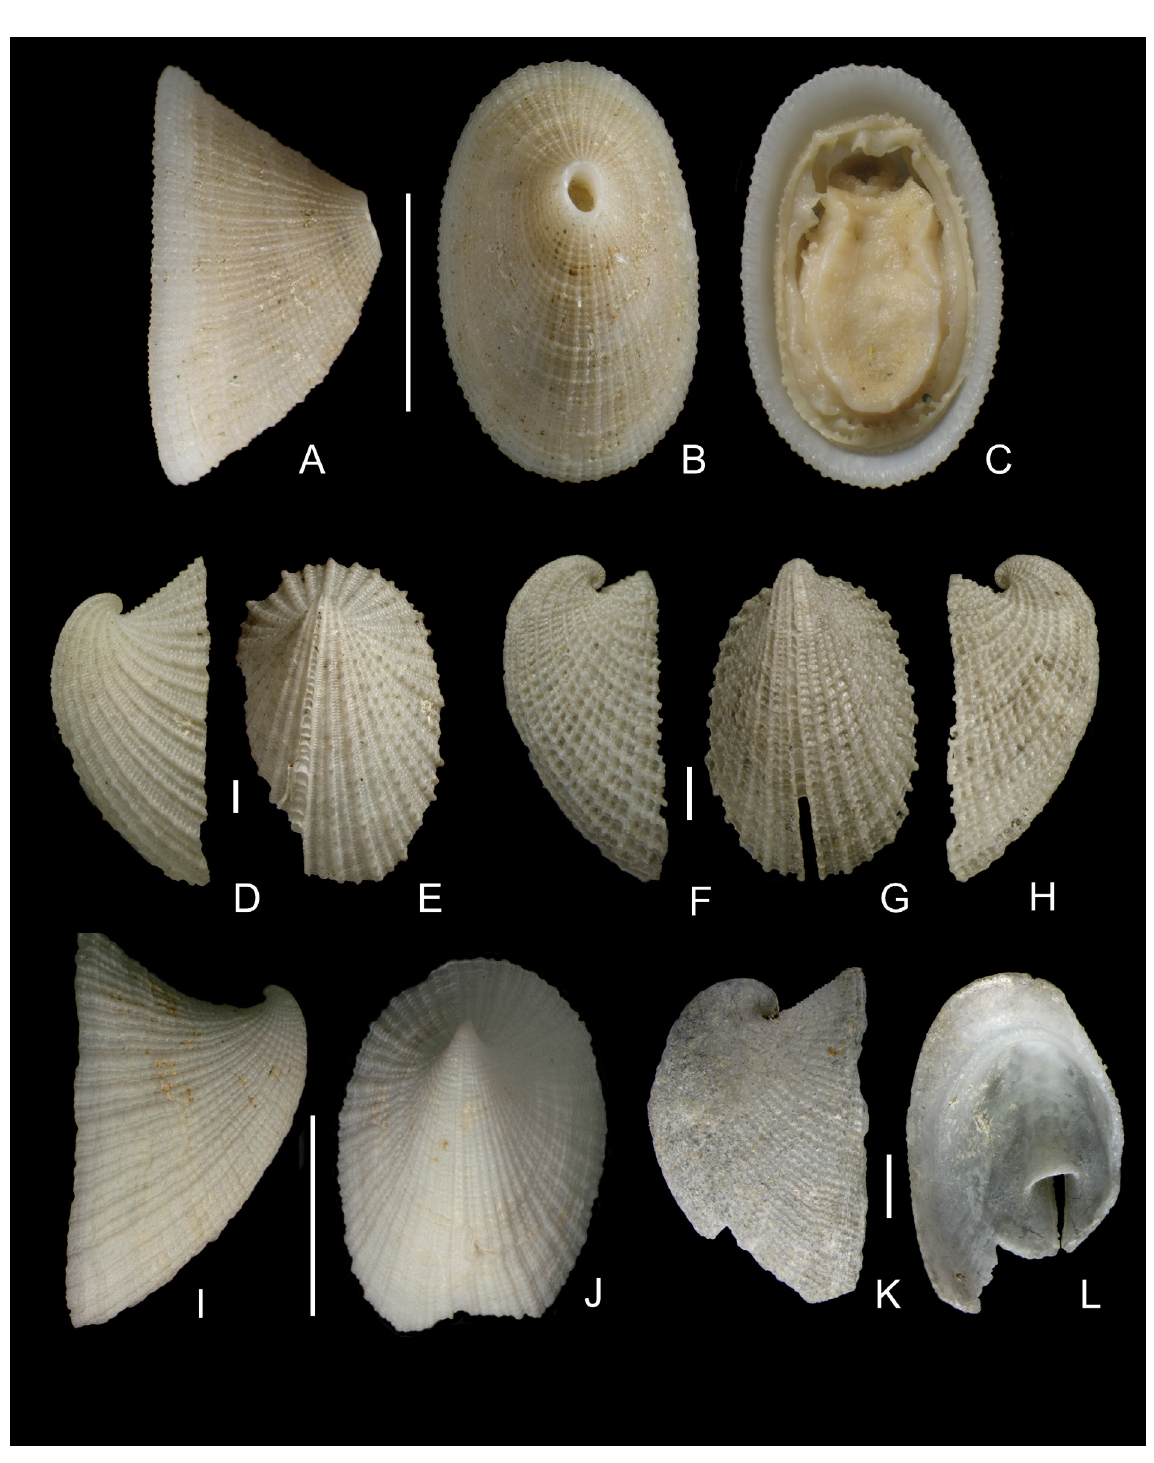
Fig. 4. Fissurellidae 1. A–C . Diodora tenuiclathrata (Seguenza, 1863), BANGAL 0711, GOC6, 903 m, 19.2 mm. D–E . Emarginula multistriata Jeffreys, 1882, SEAMOUNT 1, DW111, 675–685 m, 10.0 mm. F–H . Emarginula tuberculosa Libassi, 1859, SEAMOUNT 1, DW116, 985–1000 m, 6.1 mm. I–J . Emarginula christiaensi Piani, 1985, SEAMOUNT 1, DW106, 765 m, 20.0 mm. K–L . Puncturella 10 mm; D–H, K–L = 1